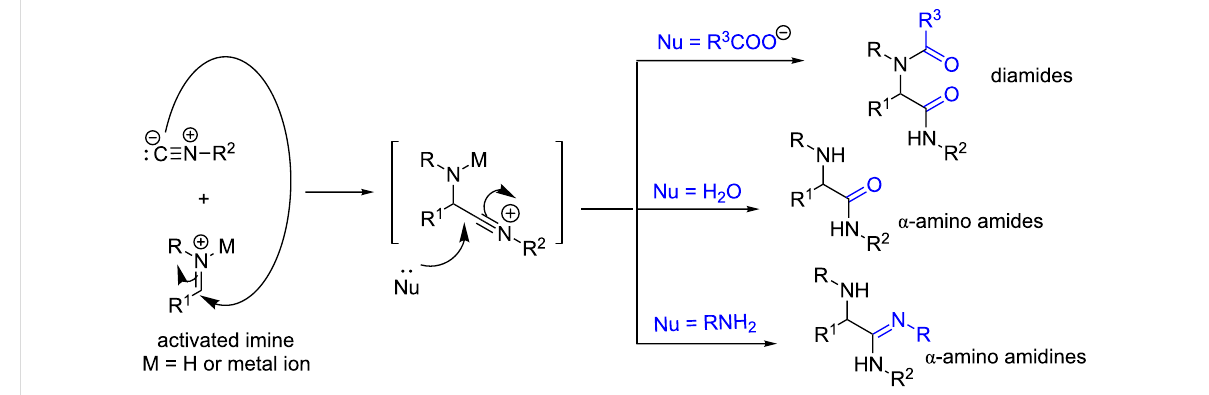
Figure 1: Synthesis of diamides, α -amino amides [13,14] and α -amino amidines [15-19] through Ugi and related MCRs.